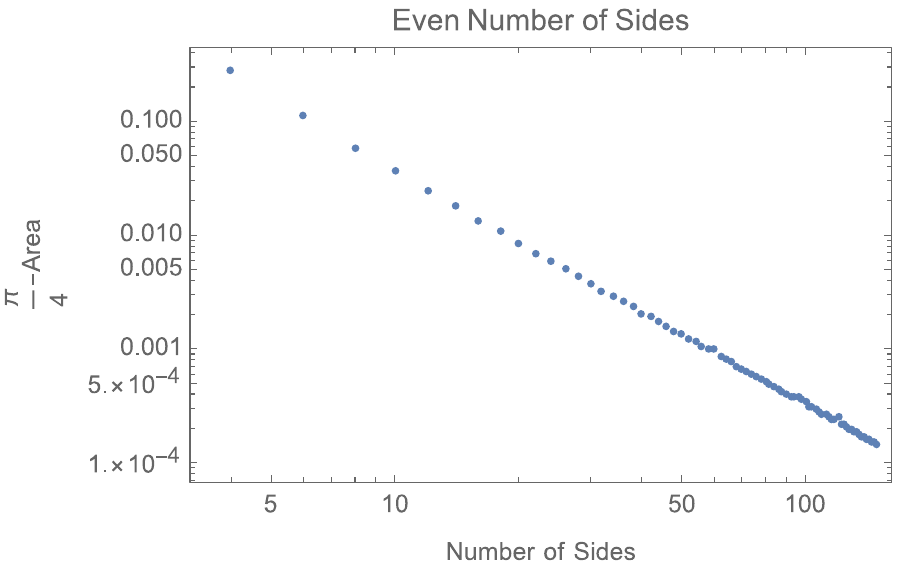
Figure 4. Difference between the area A ( n ) of the optimized polygon and π /4, for selected even values 4 ≤ n ≤ 150.